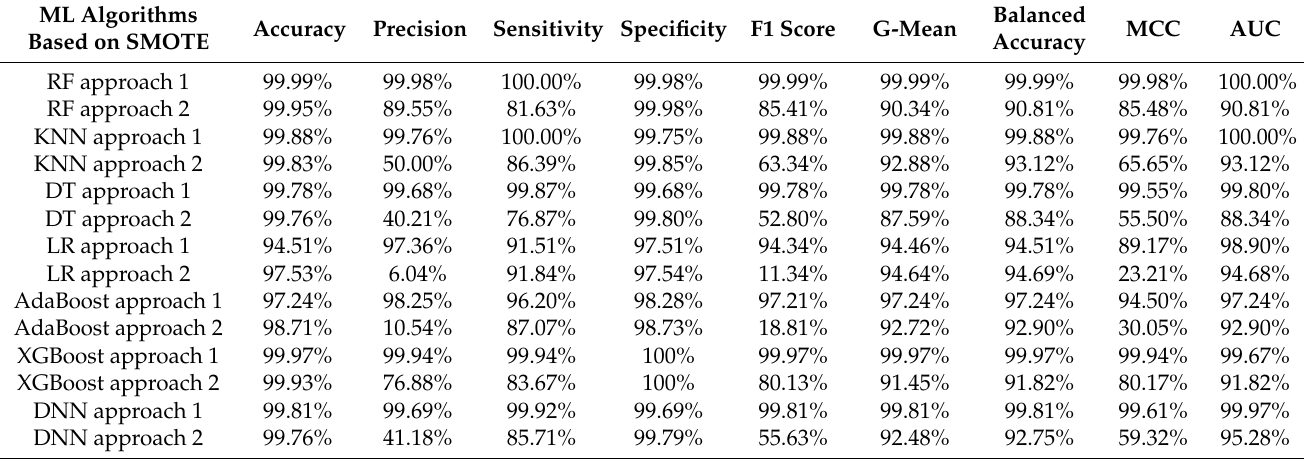
Table 13. Classification measurements indexes of ML algorithms based on SMOTE for two resampling approaches. ML Algorithms